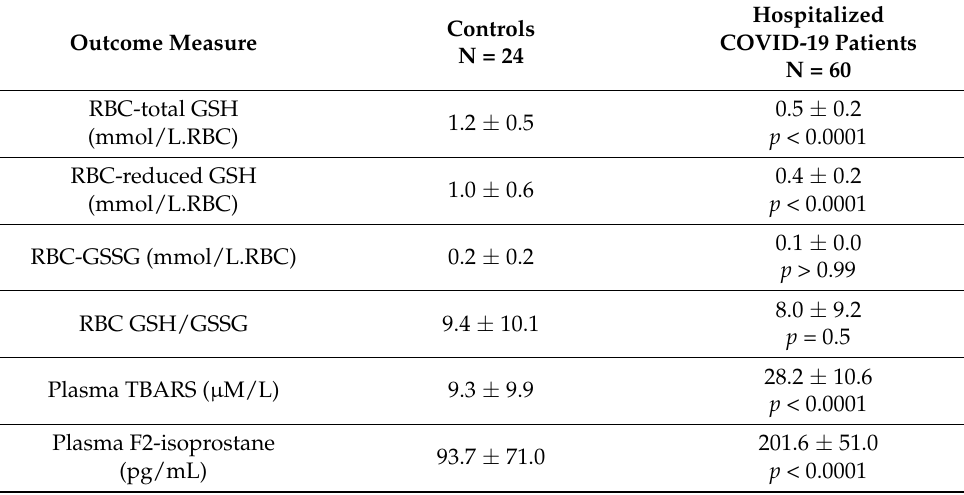
Table 2. GSH and oxidative stress. Data are reported as means ±